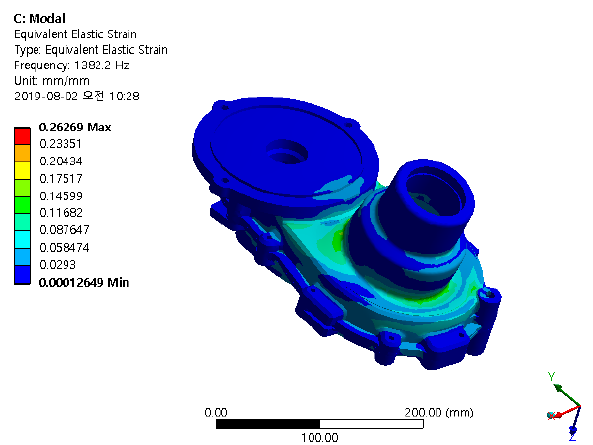
Figure 10. Elastic strain of the 1st mode.